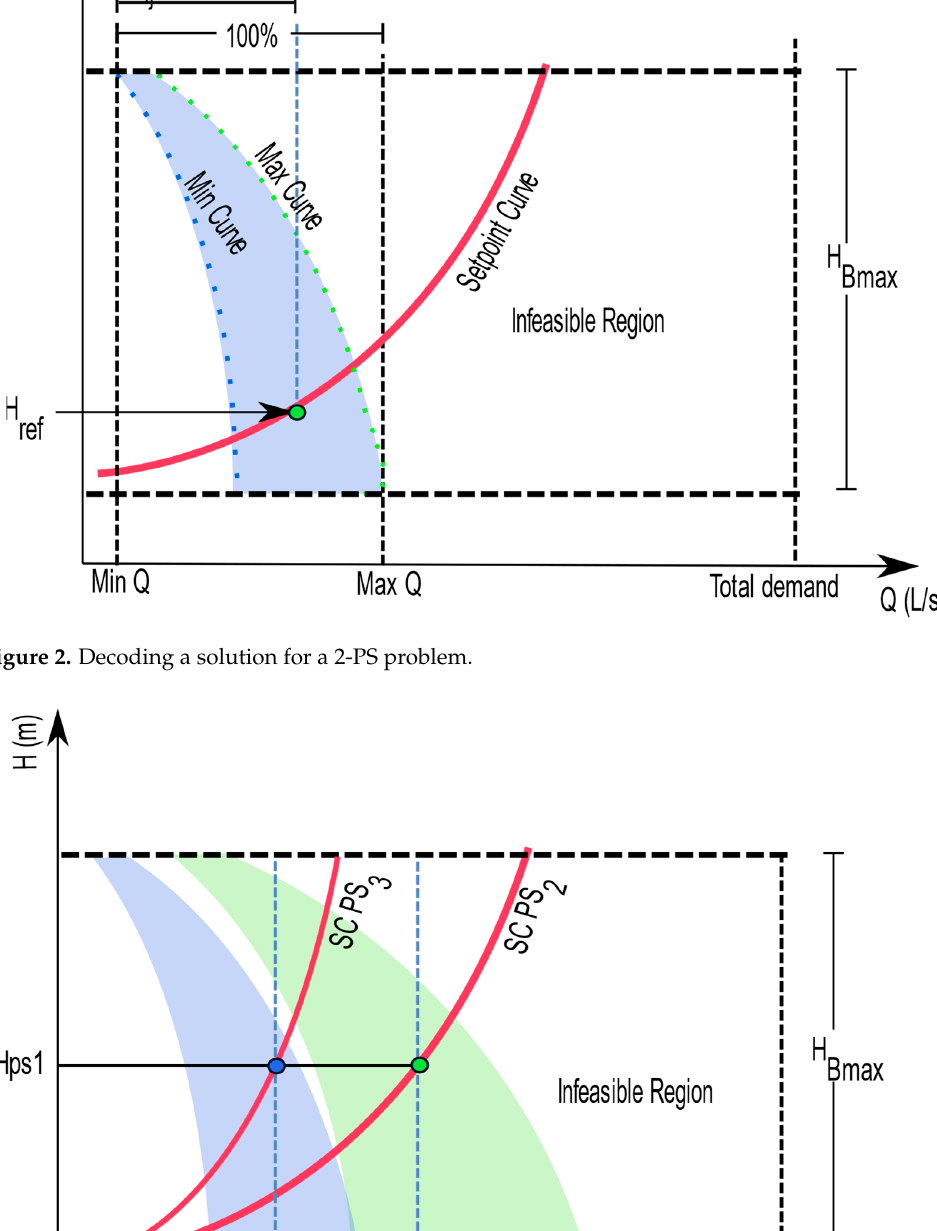
Figure 3. Decoding a solution for a 3-PS problem.